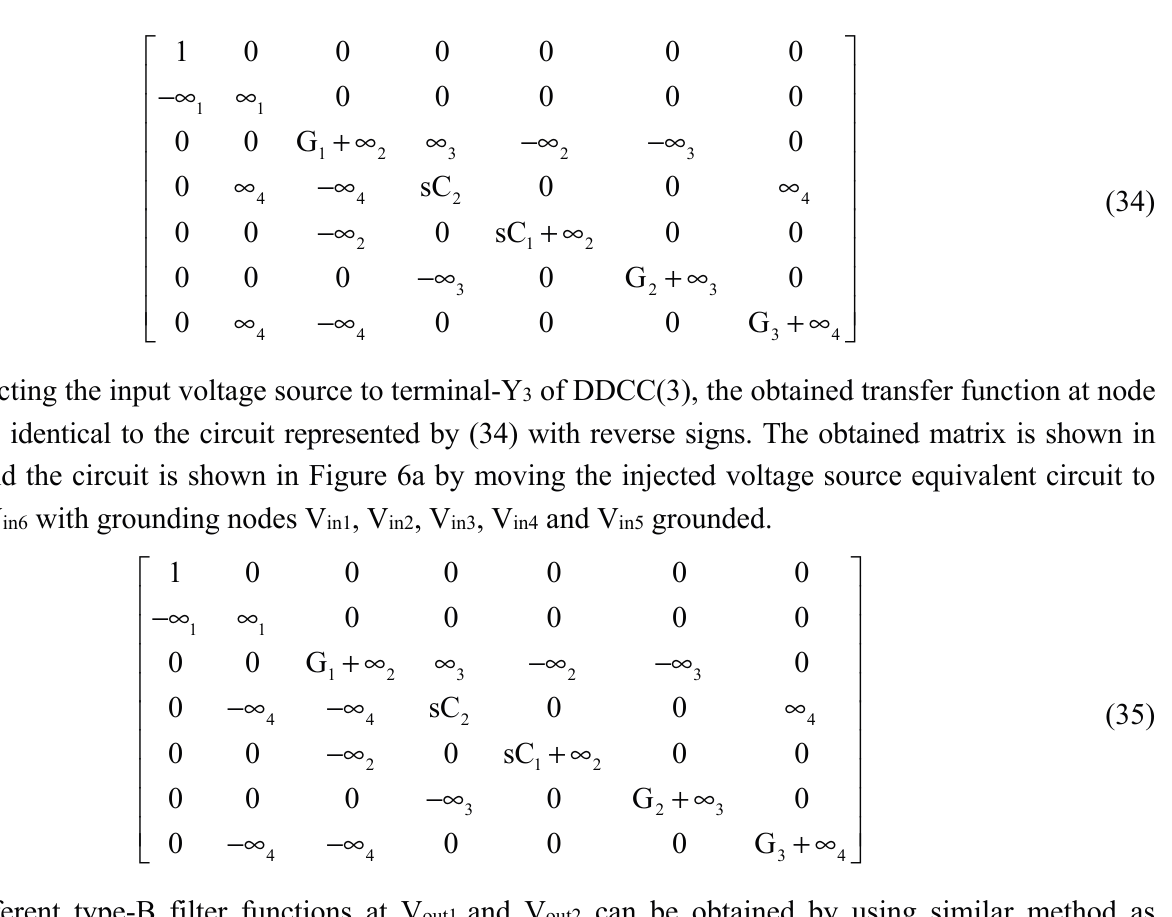
Figure 6. The pathological representations of type-B